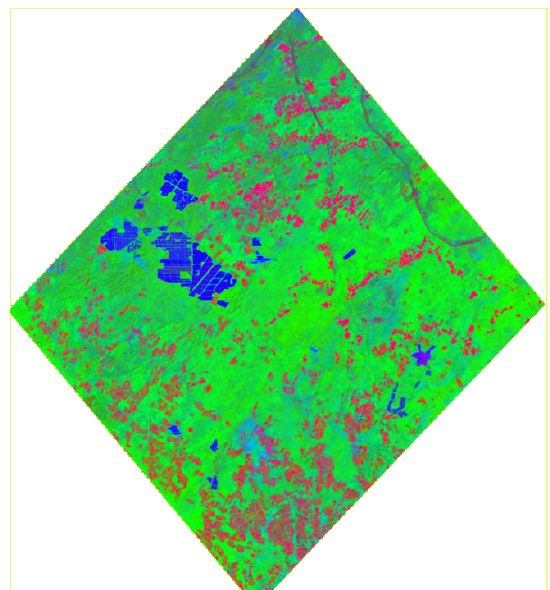
Figure 10 : Abundance image of vegetation, sand and PV panel as RGB Further to extract solar panel pixels from the data a post processing steps are carried out where the PV panel abundance image is thresholded with the value of 0.7 and ANDed with the inverse of thresholded output of sand with the value of 0.5. in figure